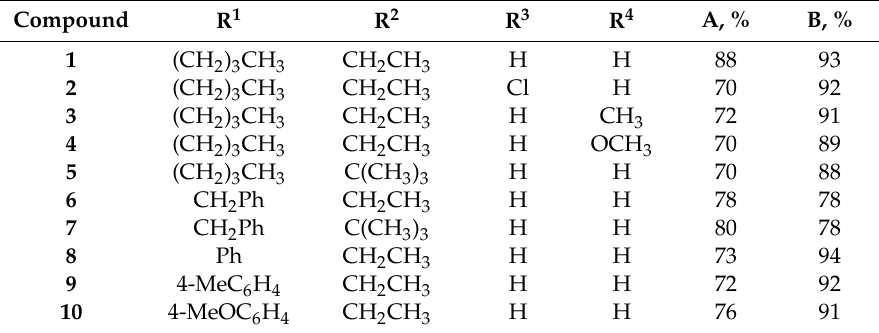
Table 1. Structures and yields of compounds A and B a .